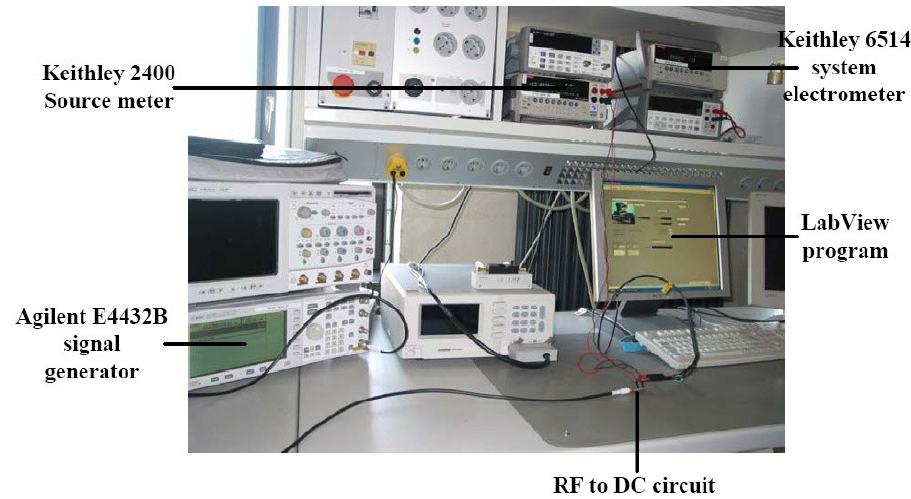
Figure A1. RF to DC Power converter characterization